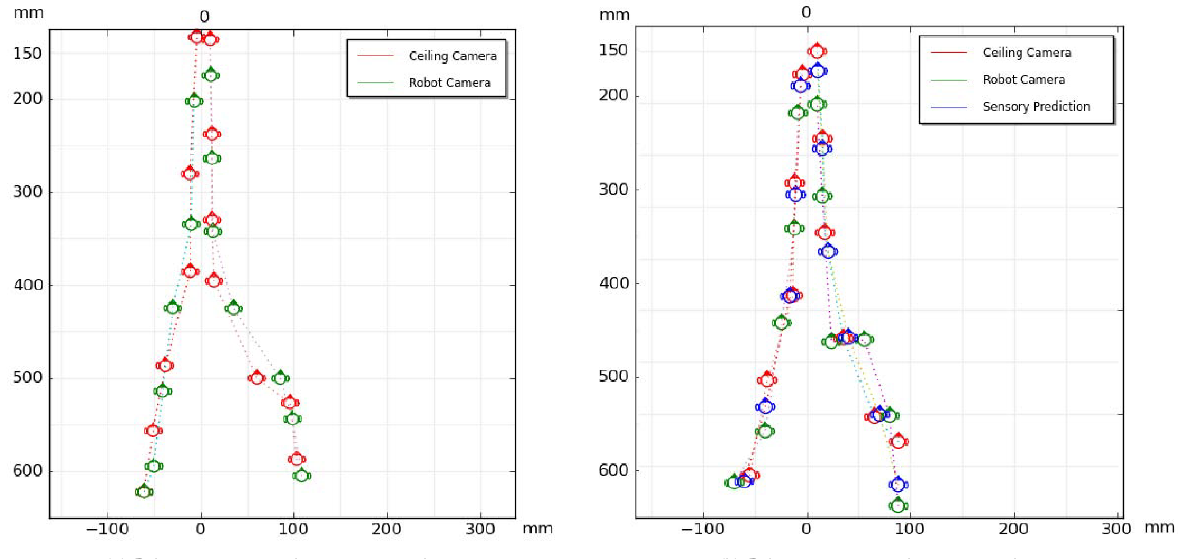
(a) Robot trajectories without sensory prediction (b) Robot trajectories with sensory prediction